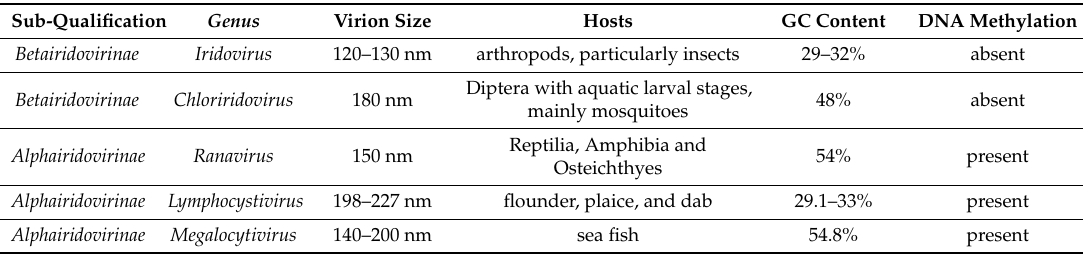
Table 1. Comparison of features of iridovirids.